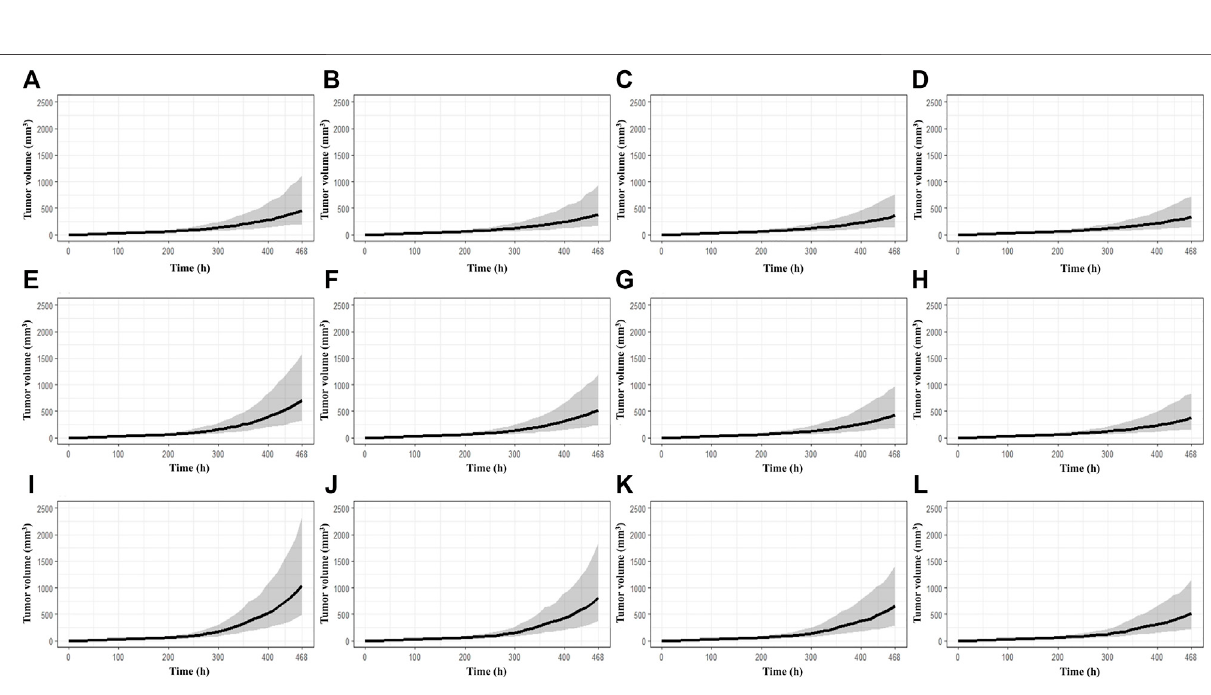
FIGURE 3 | Single-dose simulation study. (A) Tumor growth-time pro fi les (B) Dose-response relationship from single-dose (%) simulation. Blue vertical line in the panel (B) , 31.7 U kg − 1 as a predicted ED 50 ; red vertical line in the panel (B) , 74 U kg − 1 as a predicted maximum injectable dose (D max-inj. ).